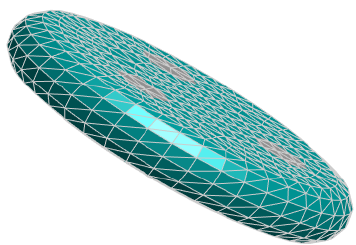
Figure 6. The units of the flexible lander.